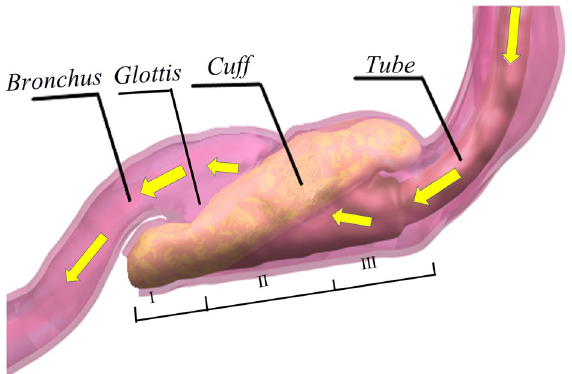
Figure 1. Pharynx with an inserted LMA (hypopharynx (I); laryngopharynx (II); oropharynx (III); yellow arrows indicating the airflow direction during positive pressure